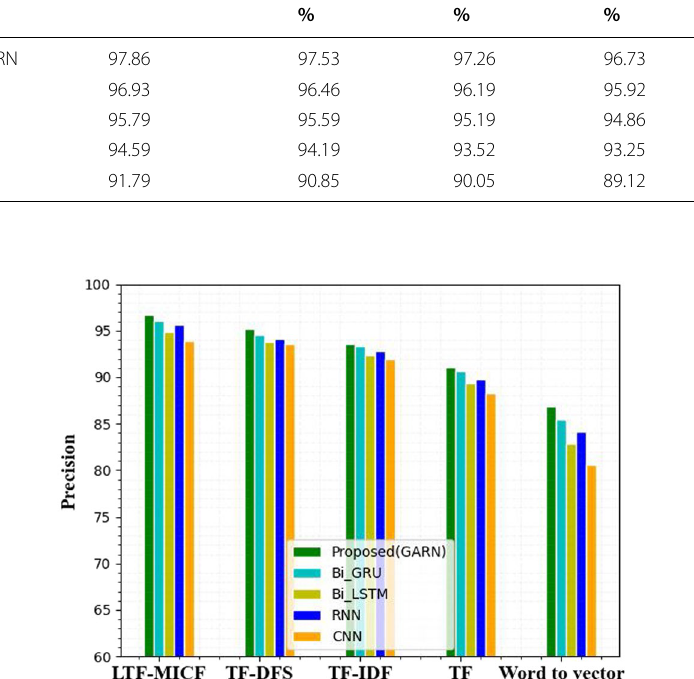
Table 5 Precision of the proposed and existing classifiers with term weights